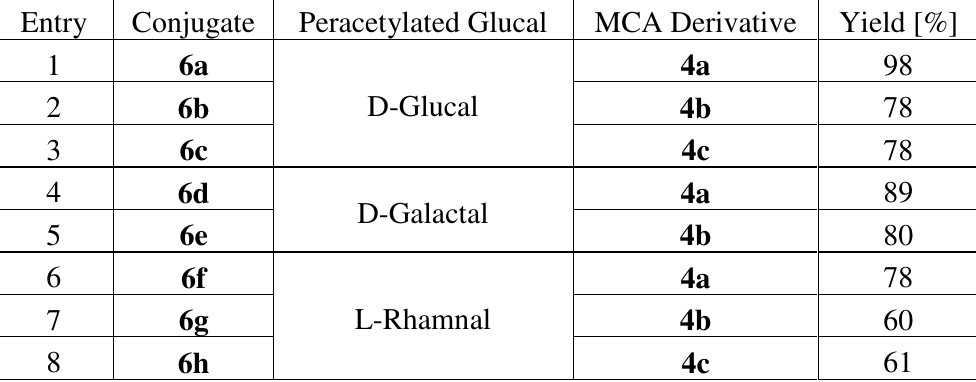
Table 1. Addition of MCA derivatives to peracetylated